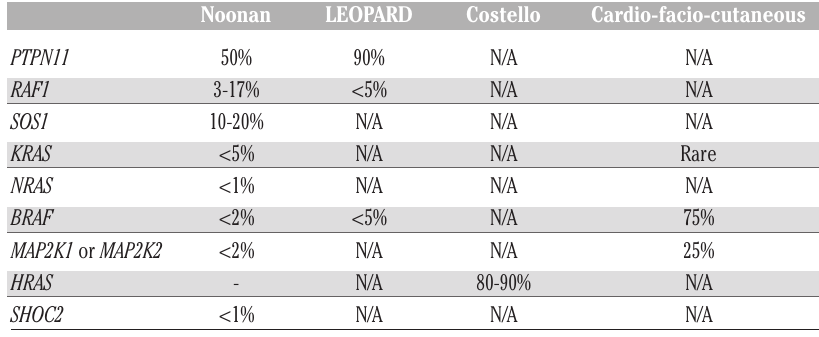
Table 1. Rasopathies with cardiac features: molecular